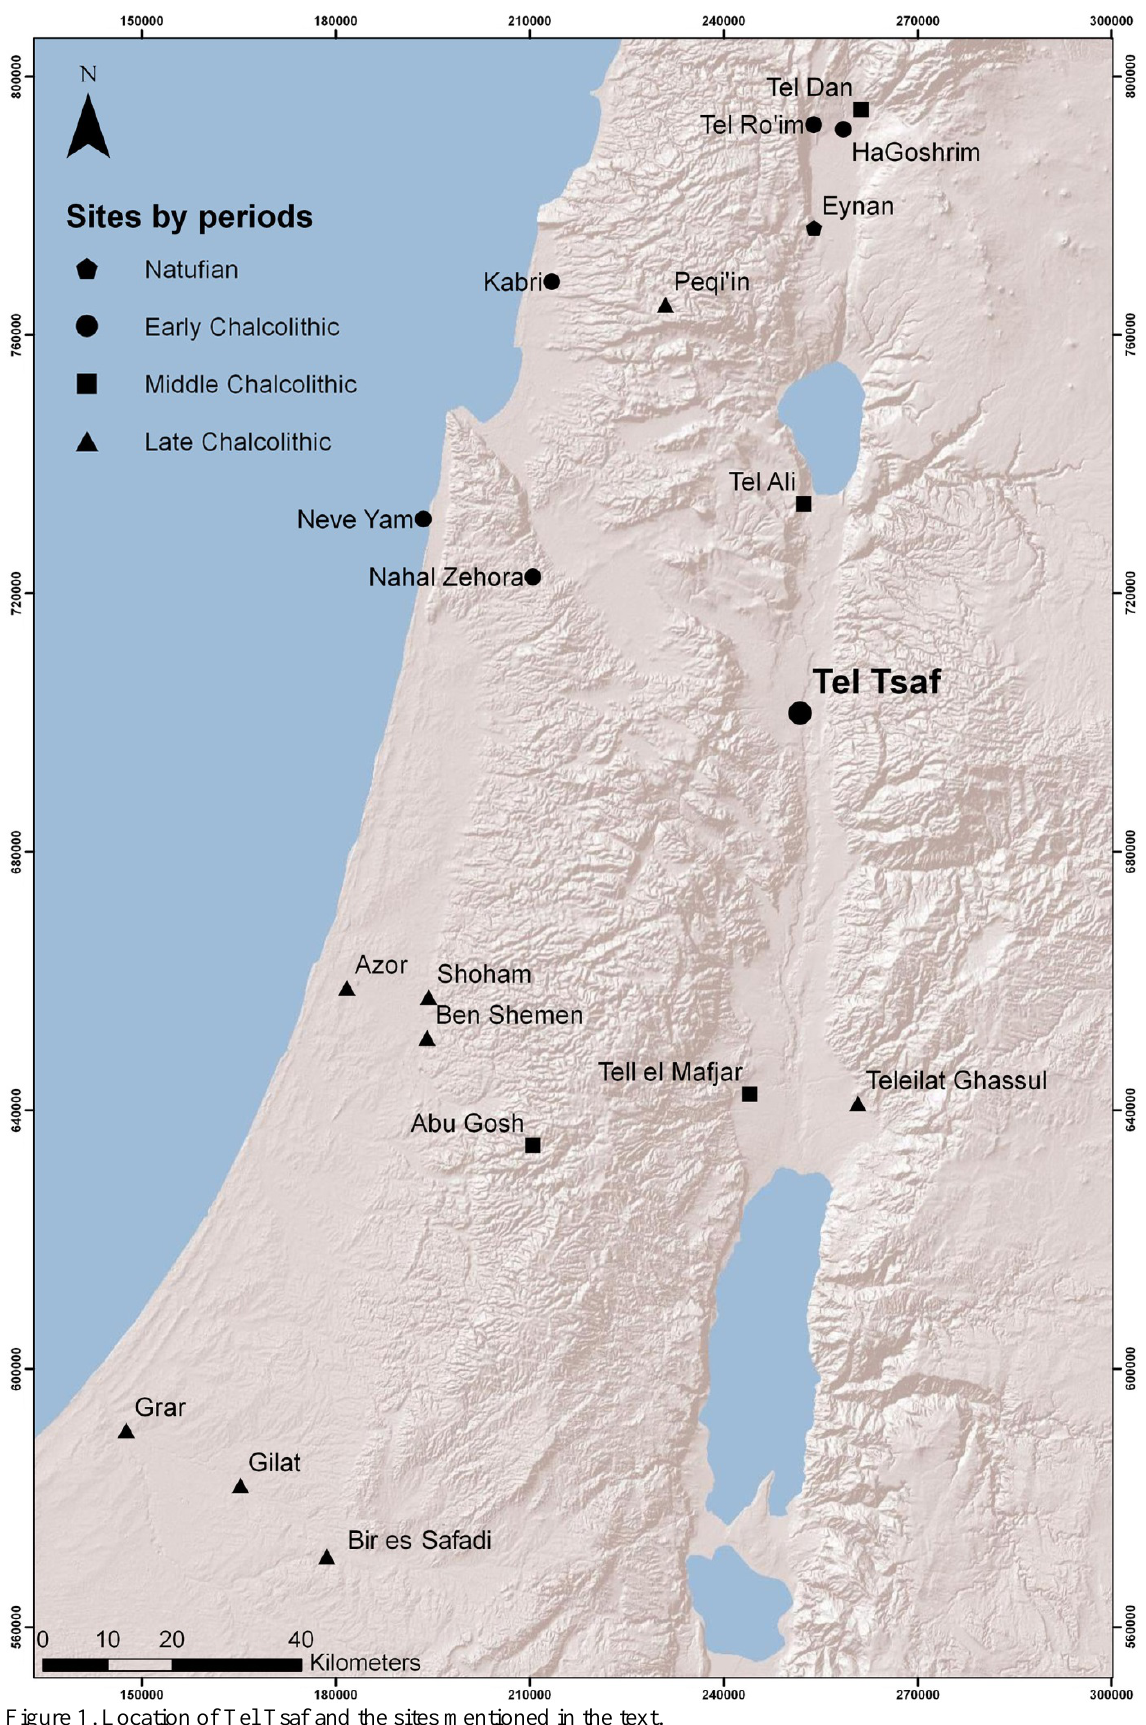
Figure 1. Location of Tel Tsaf and the sites mentioned in the